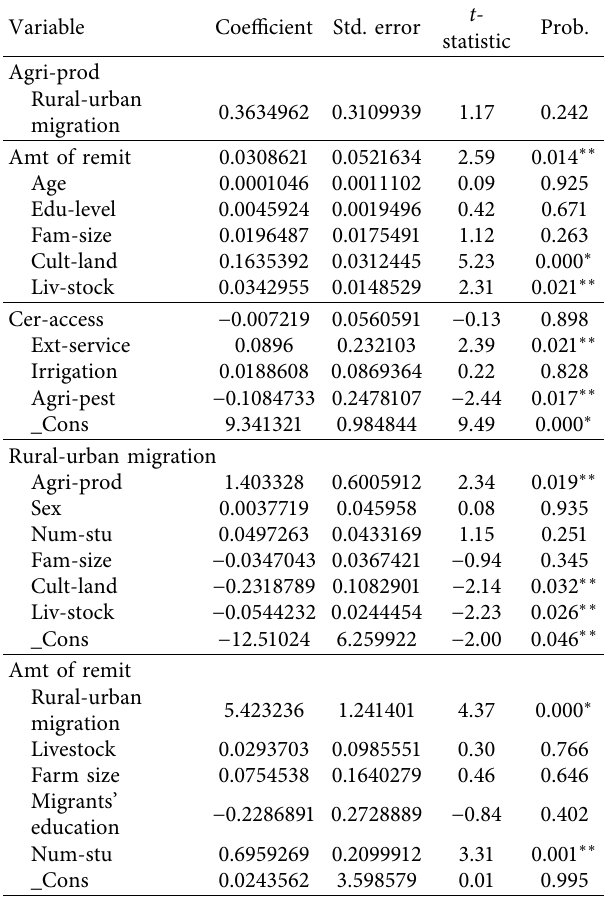
Table 4: Parameter estimation of the three-stage least square re- gression